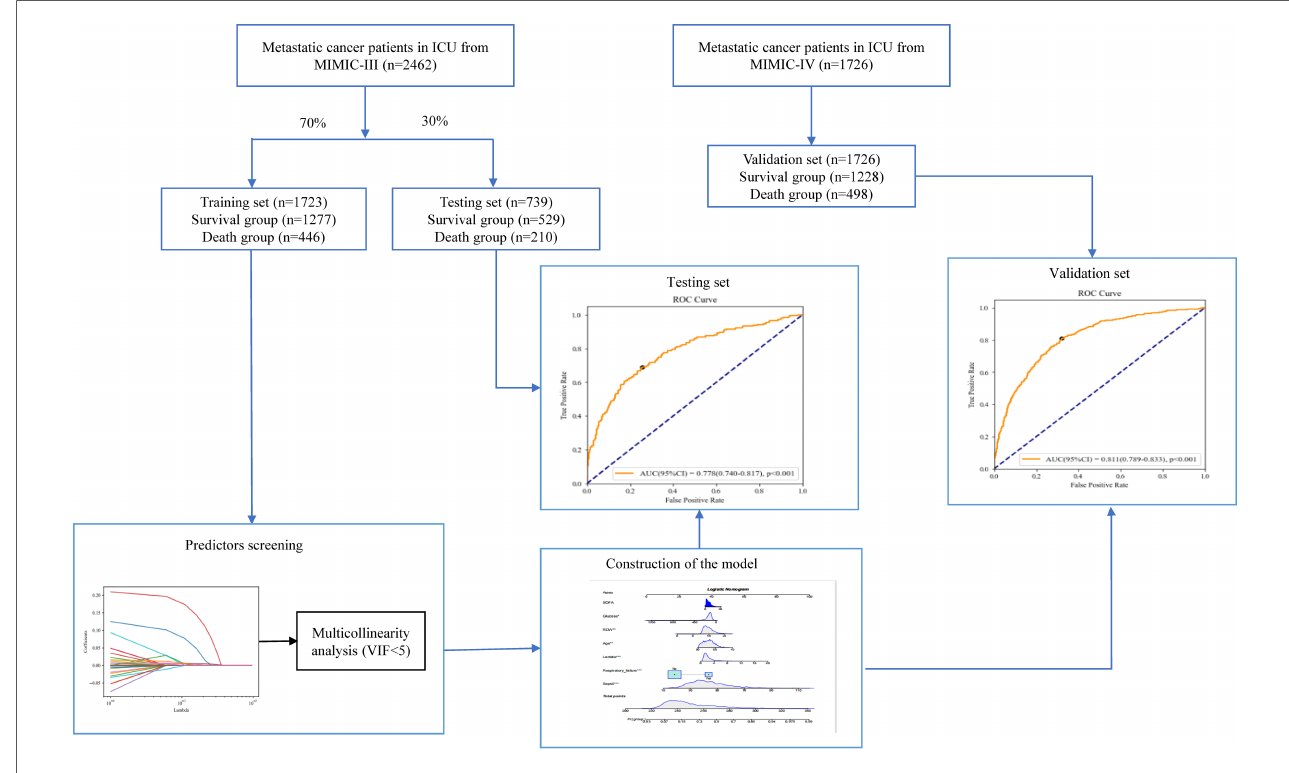
FIGURE 1 The screen process of